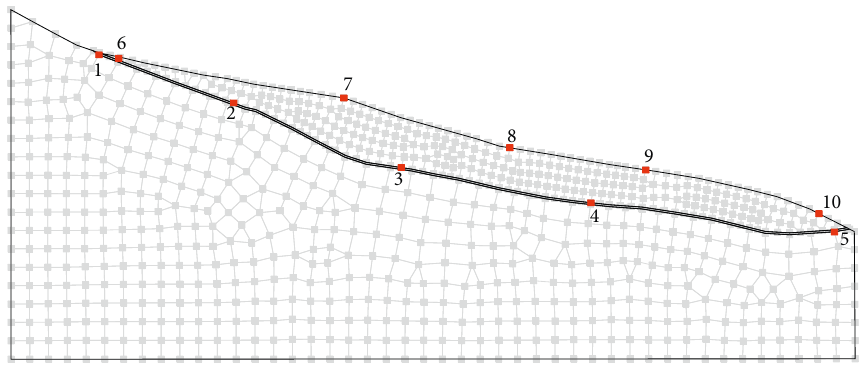
Figure 9: Schematic of the distribution of key points in the landslide.